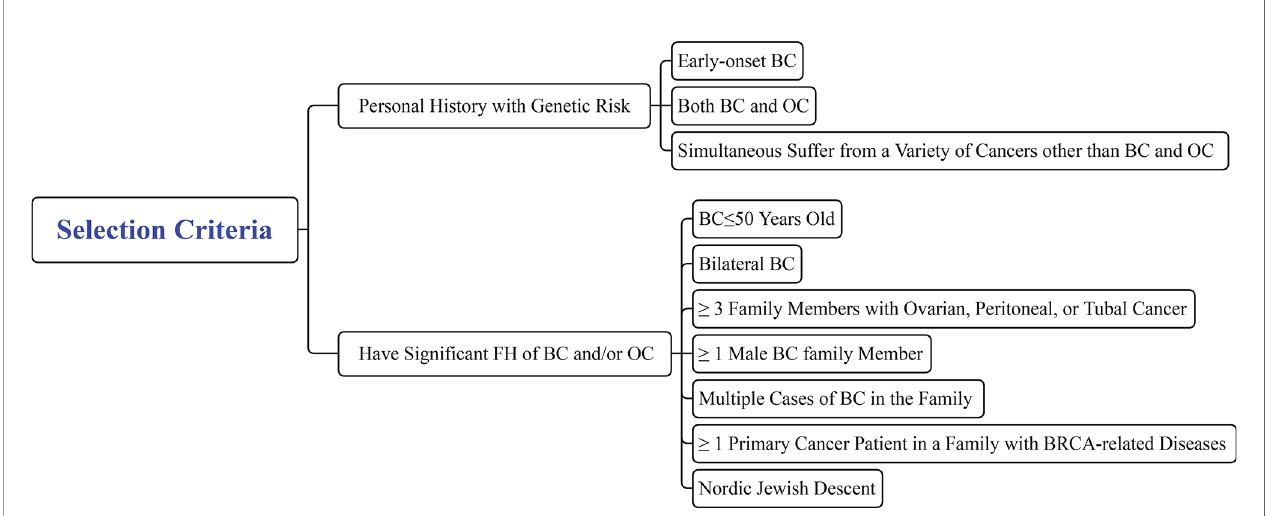
FIGURE 7 | Selection criteria for consulting